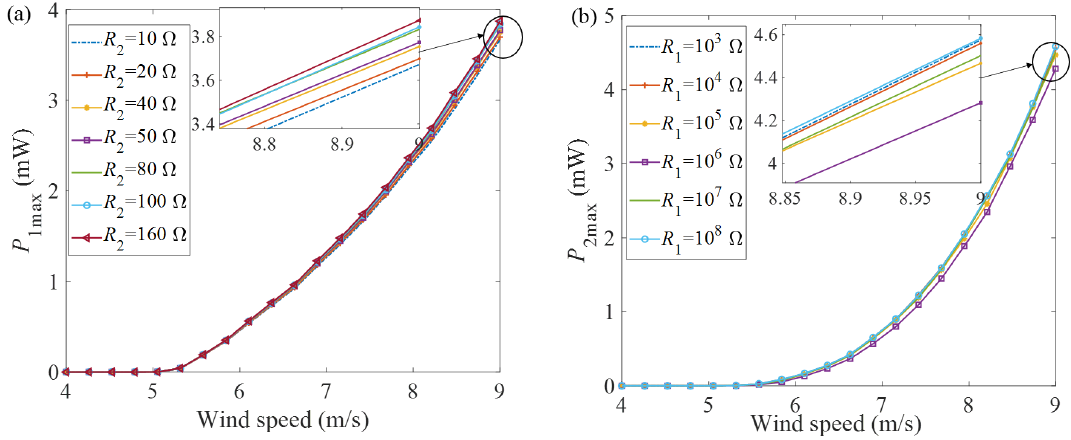
Figure 5. Curves of maximum output power with wind speed under different loads ( a ) P 1max ( b ) P 2max.